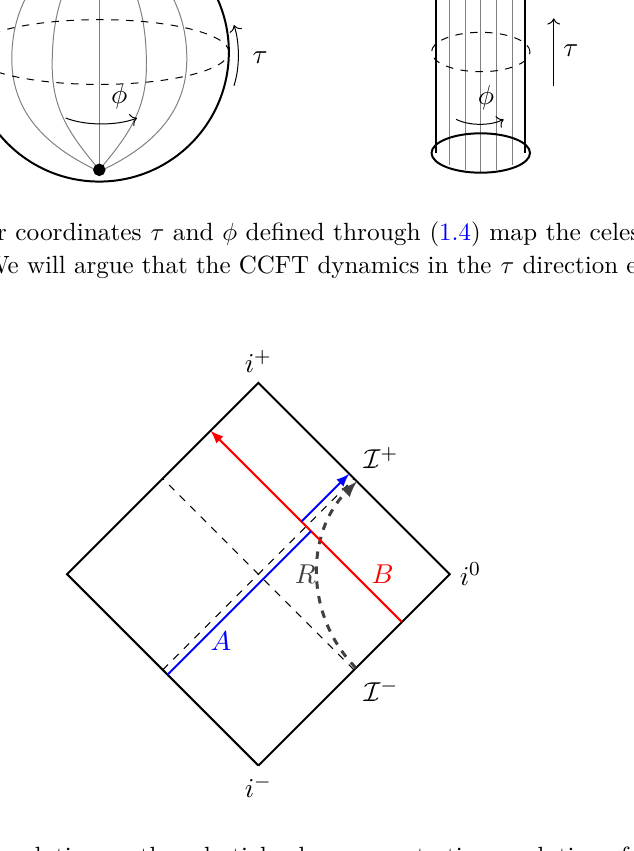
Figure 2 . Radial time evolution on the celestial sphere maps to time evolution of Rindler observer in space-time. A particle experiences a Shapiro time delay when crossing a shockwave. From the perspective of a fiducial Rindler observer, this time delay may have drastic effect that grows exponentially in